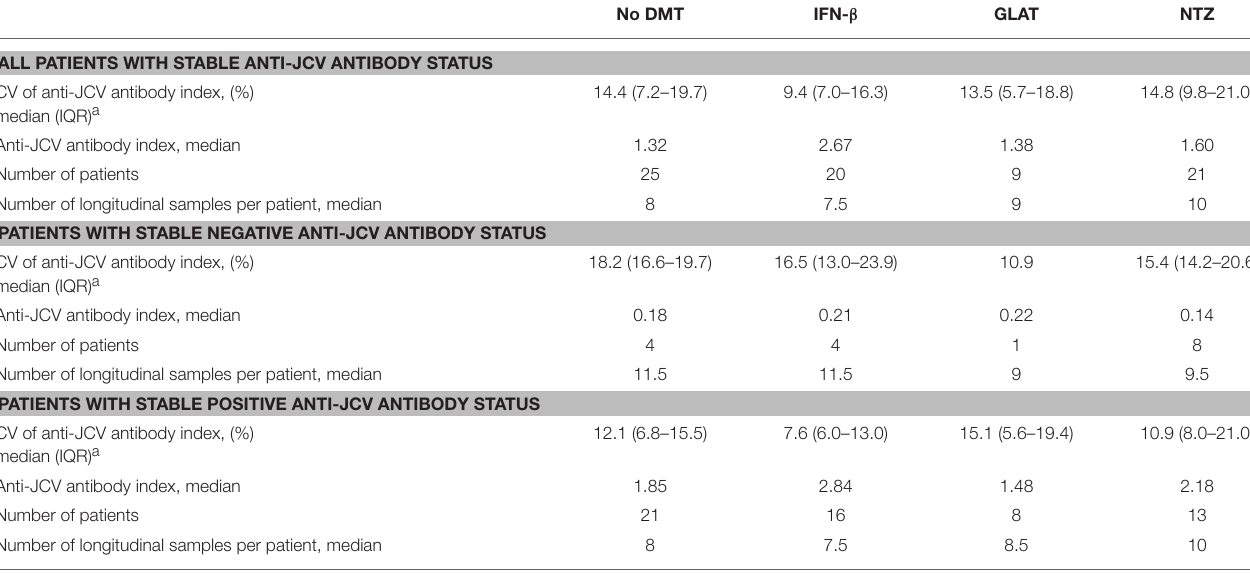
TABLE 2 | Variability of longitudinal anti-JCV antibody index in patients with stable anti-JCV antibody status. No DMT IFN- β GLAT NTZ